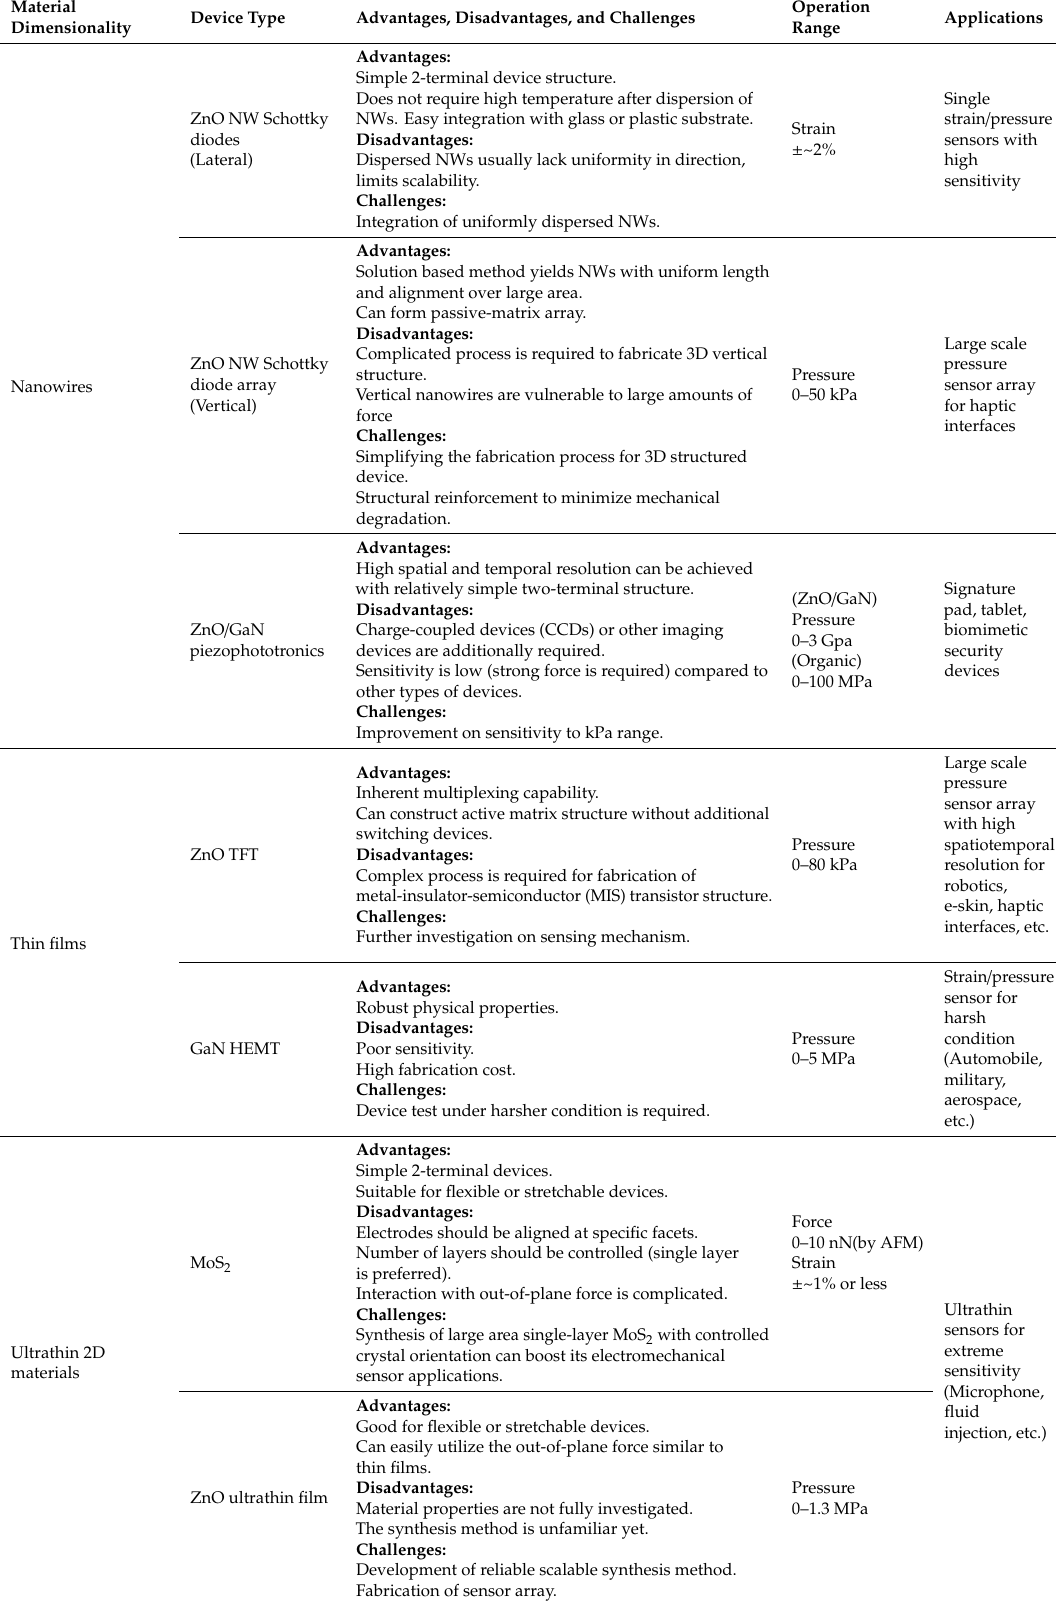
Table 8. Advantages, disadvantages, challenges, operation range, and applications for di ff erent types of piezoelectric